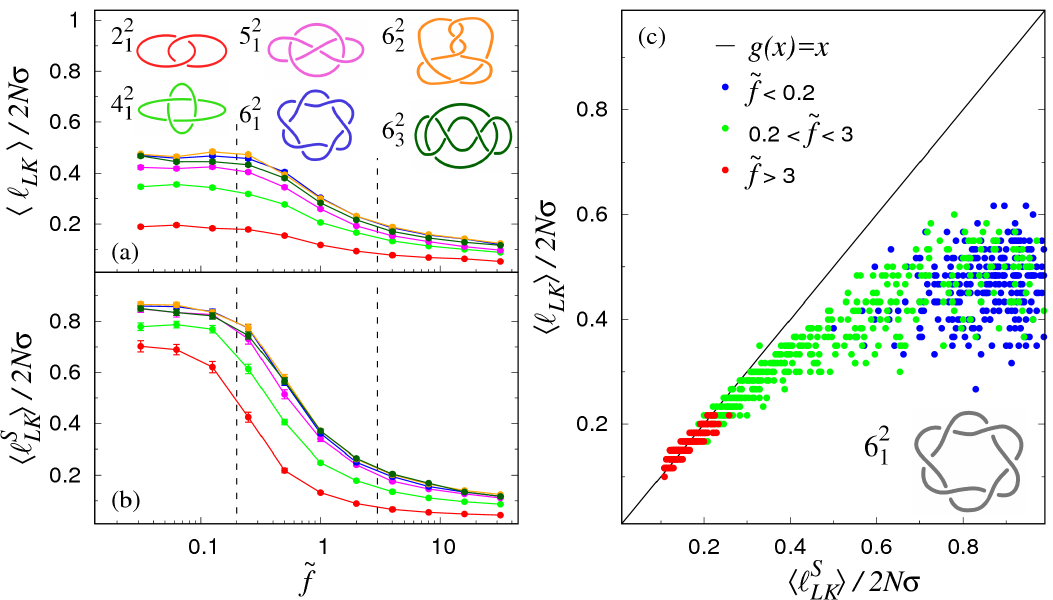
Figure 5. ( a ) Average contour length of the linked portion, (cid:104) (cid:96) LK (cid:105) , as a function of the reduced pulling force ˜ f = f σ . Different curves refer to different link types, as shown in the legend. The vertical lines k B T are visual guides that approximately separate the weak ( ˜ f ∼ < 0.25), intermediate (0.25 ∼ < ˜ f ∼ < 3), and (cid:105) , from the sliding planes method, is strong ( ˜ f ∼ > 3) force regimes; ( b ) Same as in ( a ), but where (cid:104) (cid:96) S LK (cid:105) obtained for used in place of the actual linked portion length; ( c ) Scatter plot of (cid:104) (cid:96) LK (cid:105) versus (cid:104) (cid:96) S LK various linked configurations sampled at different values of the reduced force ˜ f (see